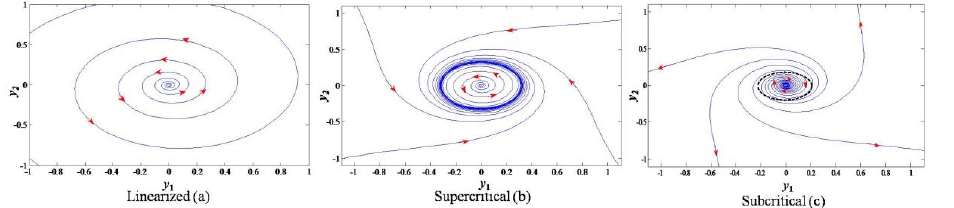
Figure 1. Phase portrait of ( a ) linearized system, ( b ) supercritical; and ( c ) subcritical Andronov–Hopf bifurcations, where α = 0.1, and the arrows point out the time evolution